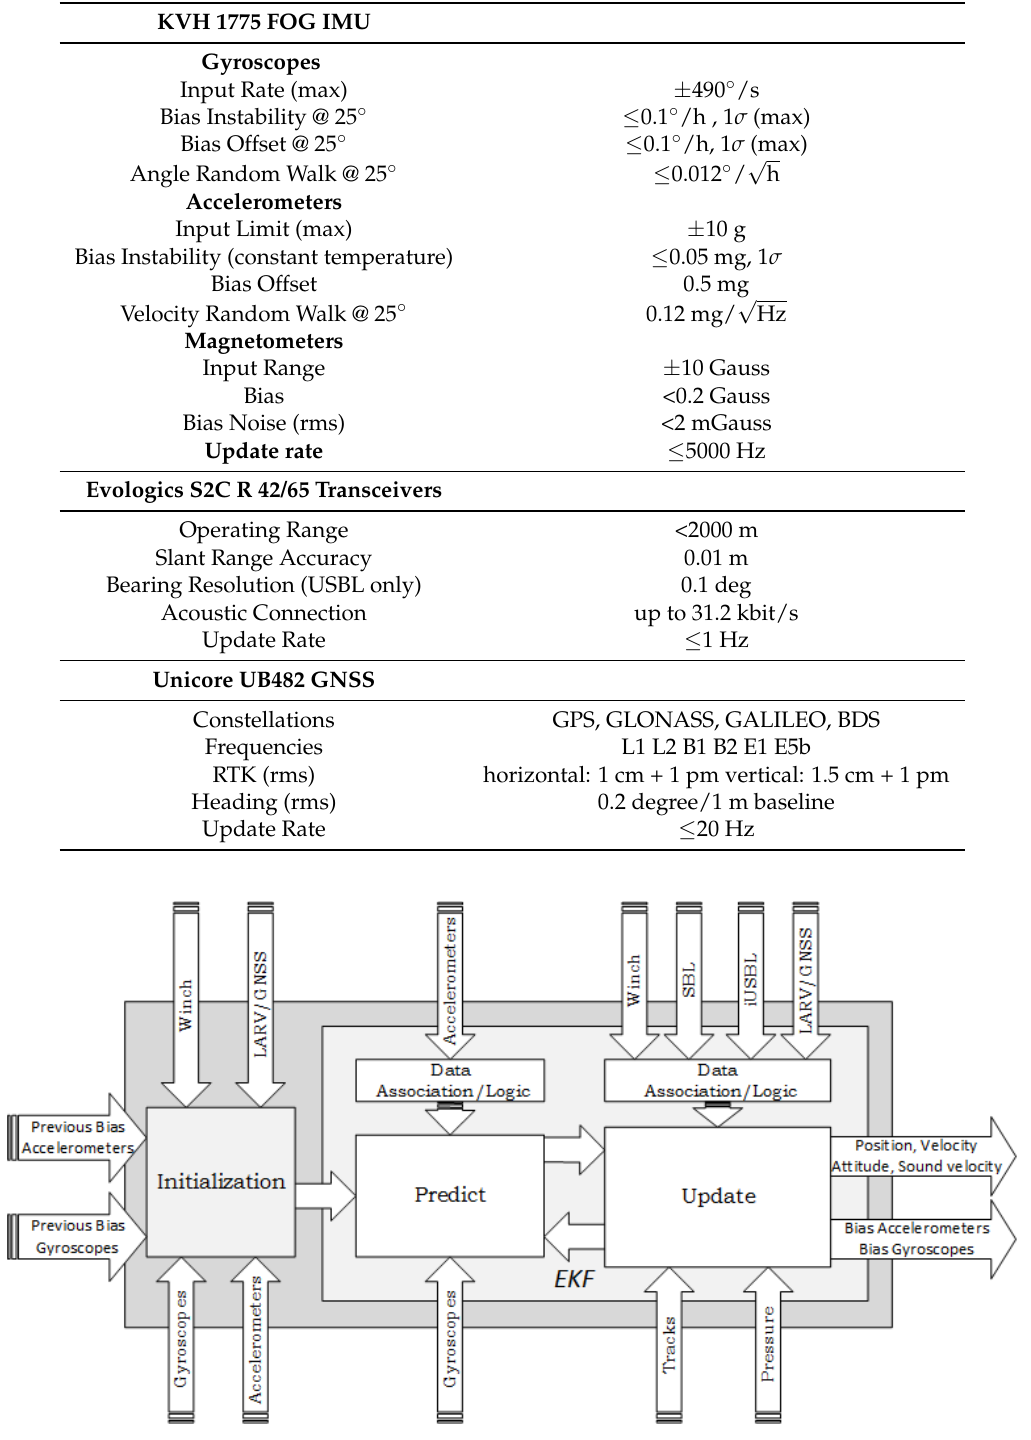
Figure 5. Architecture of the localization method developed for the